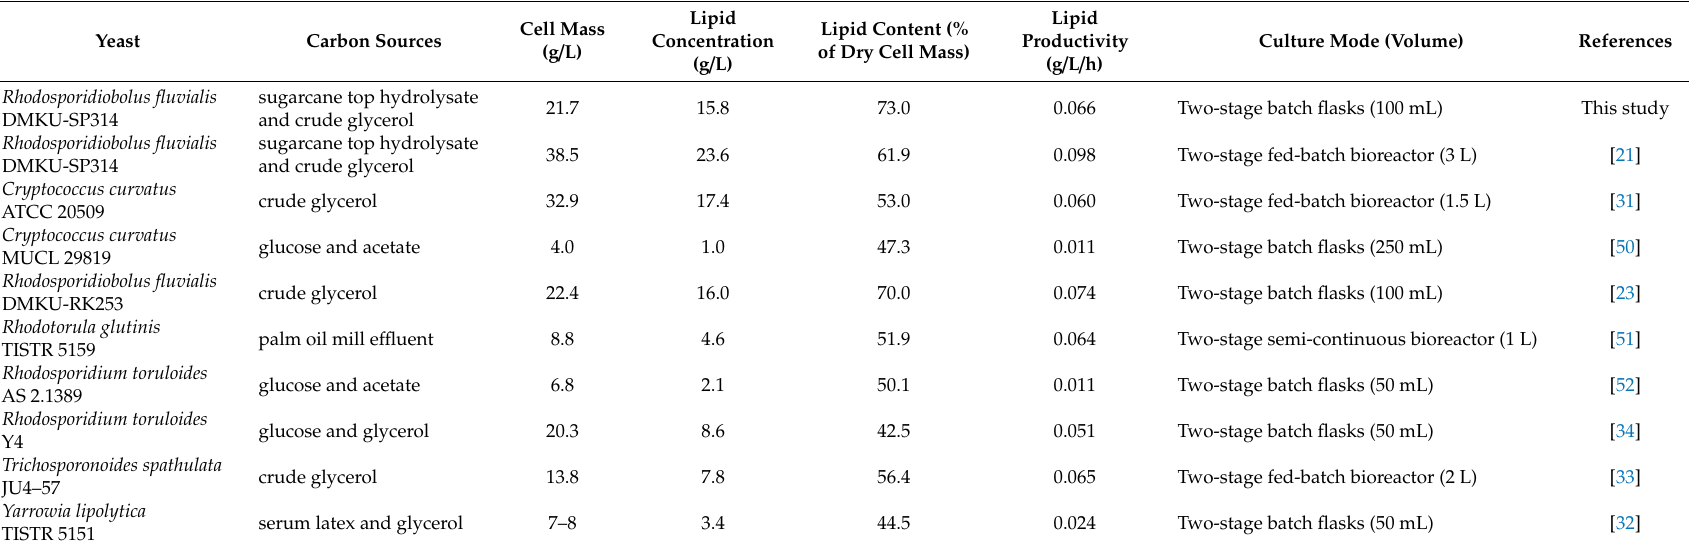
Table 6. Comparative study of lipid productivity by oleaginous yeasts cultivated in various substrates using two-stage cultivation.